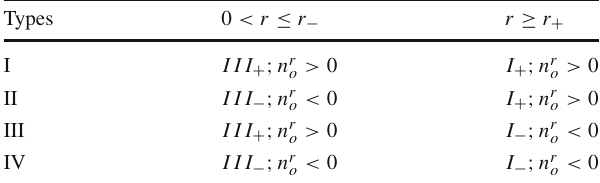
Table 1 The four possible types of oscillation trajectories on the Pen- rose diagram, as well as each corresponding region as, are listed